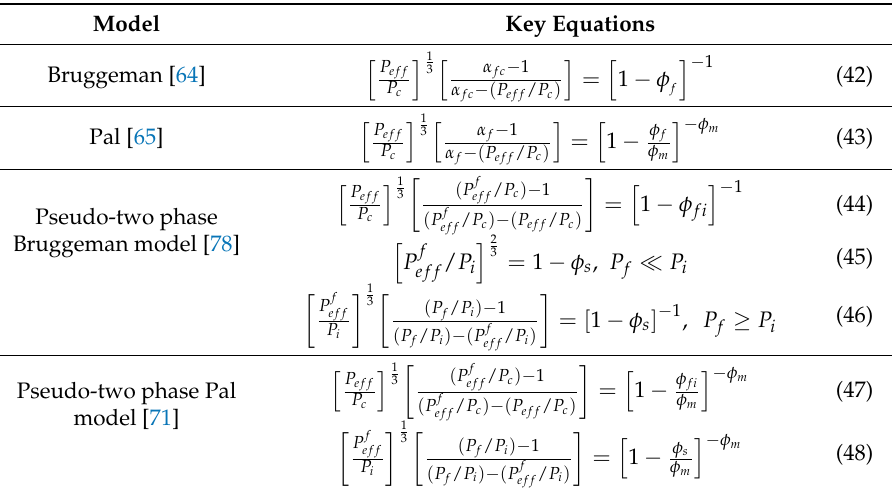
Table 3. Models based on Bruggeman’s